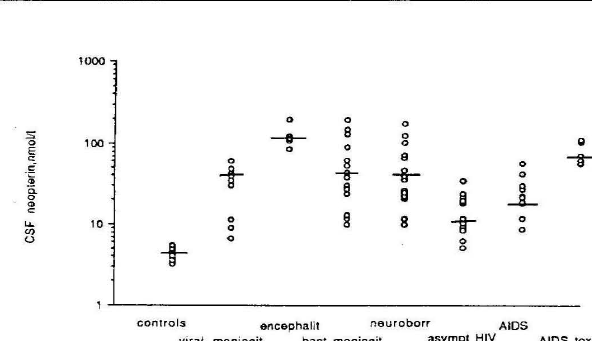
Figure 1. Cerebrospinal fluid neopterin concentrations in various central nervous system infections. Neopterin was analysed with a radioommuno assay (Henning,